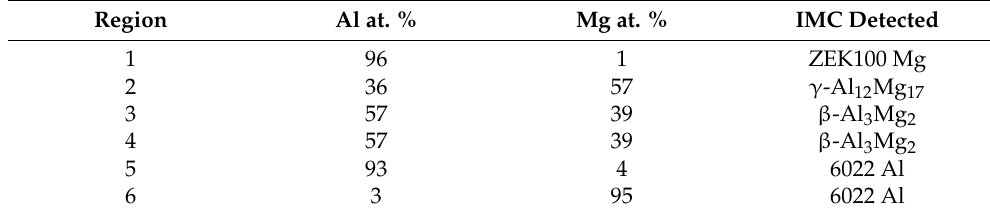
Figure 8. ( a ) STEM ZC micrograph of the interfacial layer between FSW 6022 Al and ZEK100 Mg; ( b ) XRD analysis that shows evidence of IMCs. Table 3. Index of quantitative EDS